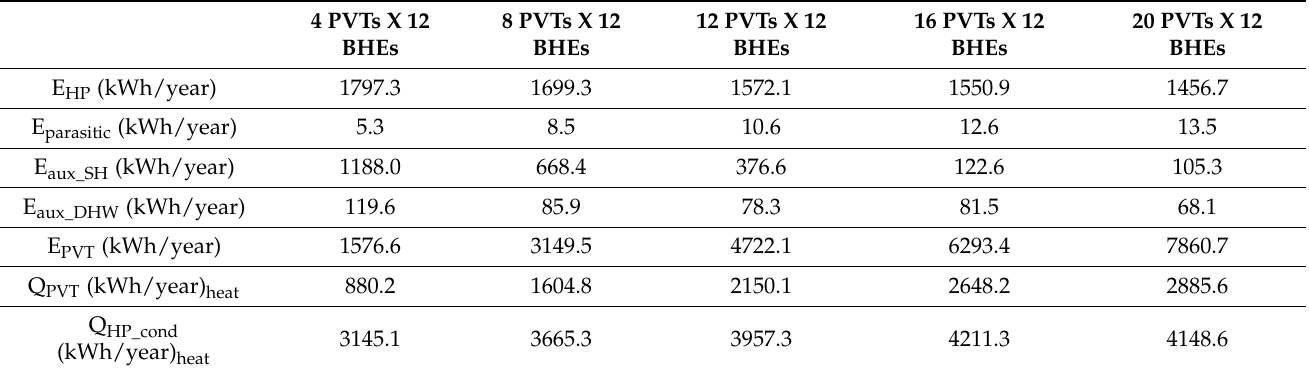
Table 5. Annual electric energy (E) consumed on the SAGSHP system and the annual electricity and heat produced by the PVTs, along with the heat provided by the heat pump for Athens.